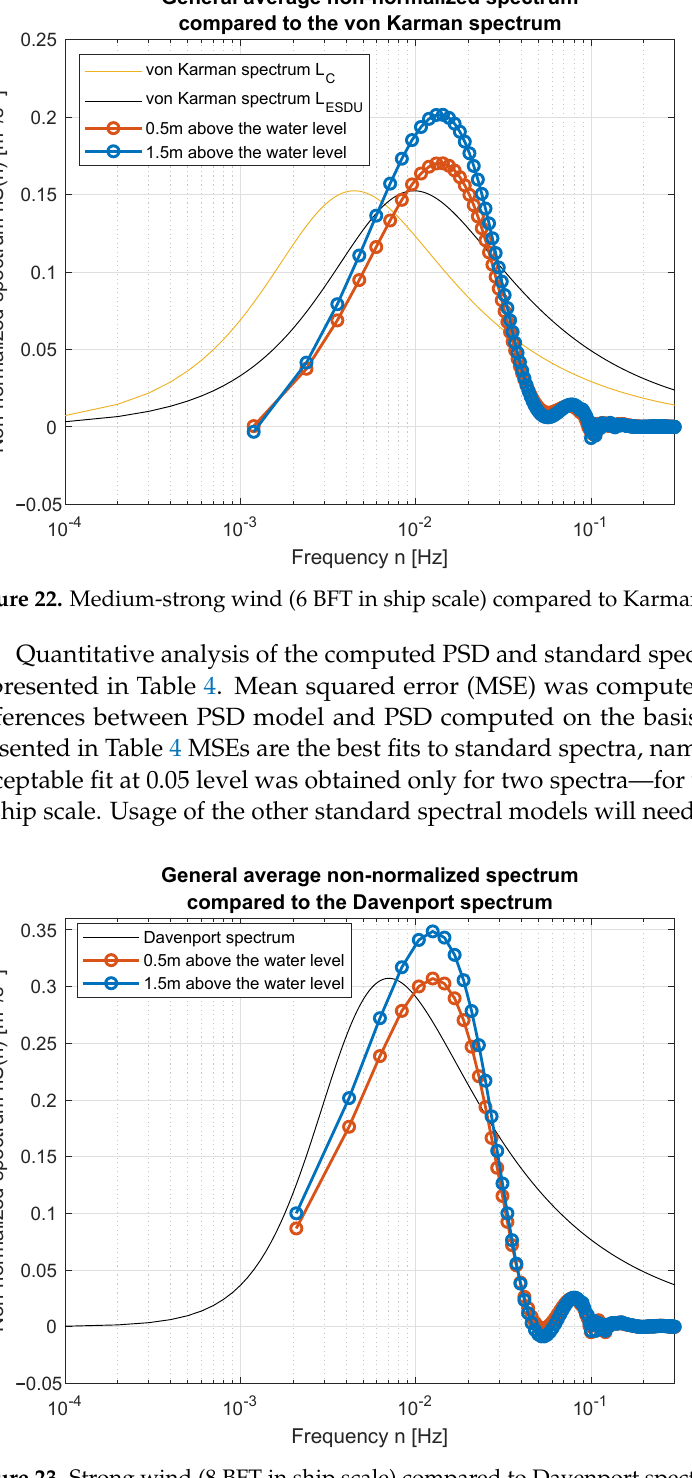
Figure 23. Strong wind (8 BFT in ship scale) compared to Davenport